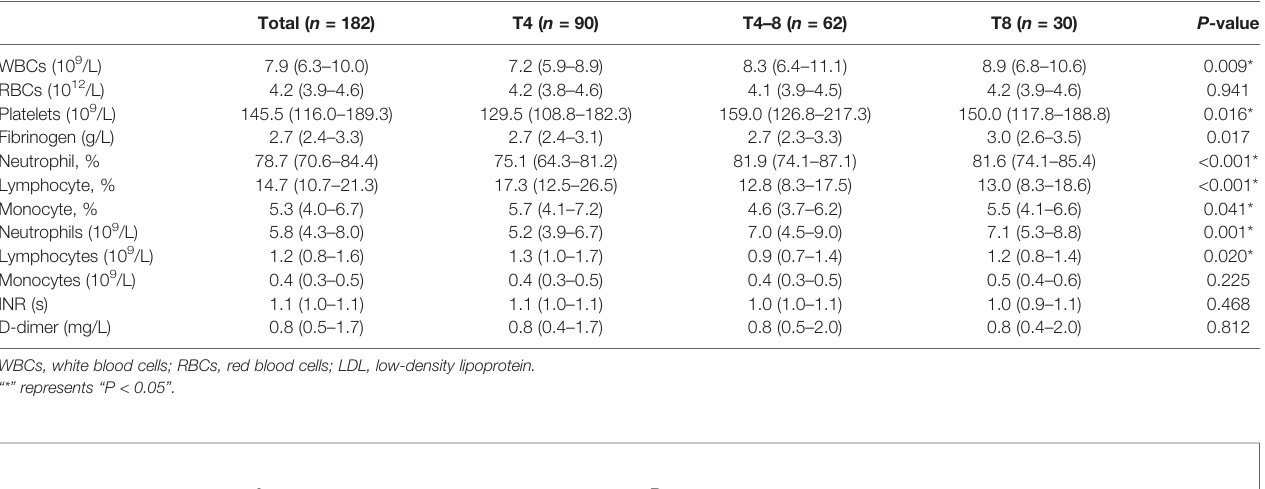
TABLE 2 | Changes in the peripheral blood of all patients.